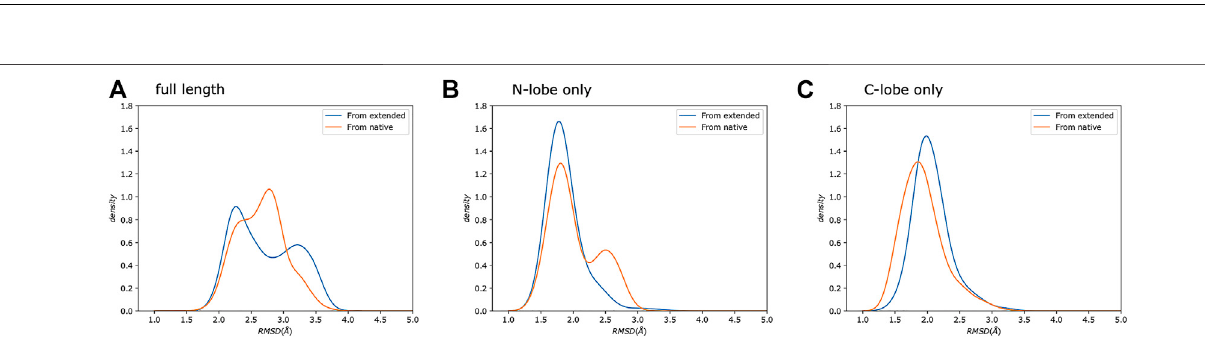
FIGURE5| Thedomainshavetightlyclusteredensembles.Superpositionsof (A) C-lobe(residues82 – 149)and (B) N-lobe(residues1 – 76)ofCalmodulinforTrial3. Every 100th frame from the last 0.5 microseconds is shown, coloured from N-terminus (red) to C-terminus (blue).